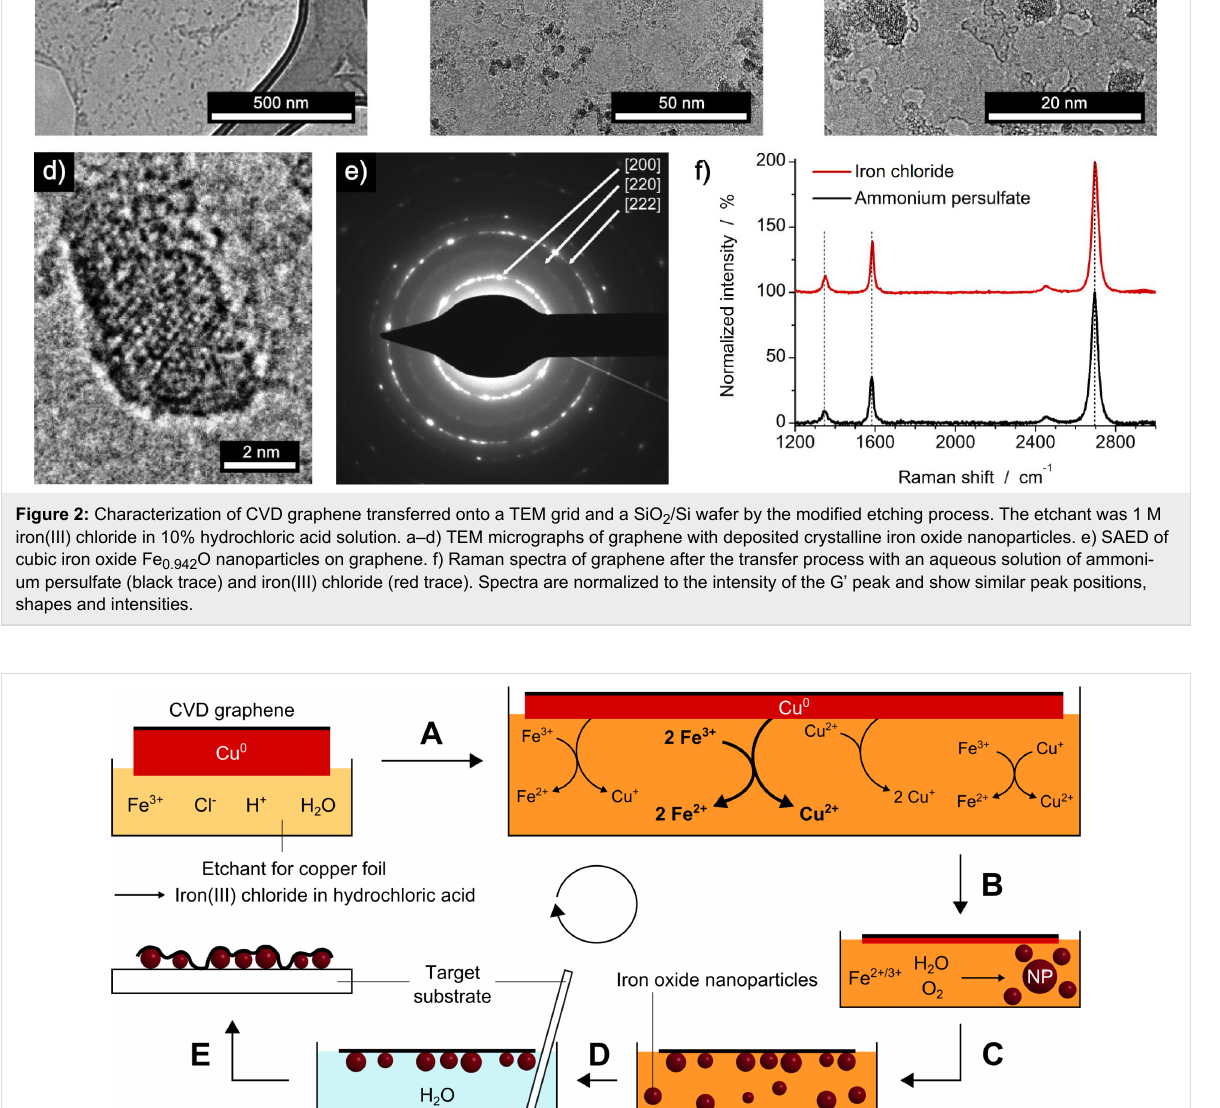
process by adapting the ratio of copper substrate to iron(III) etchant